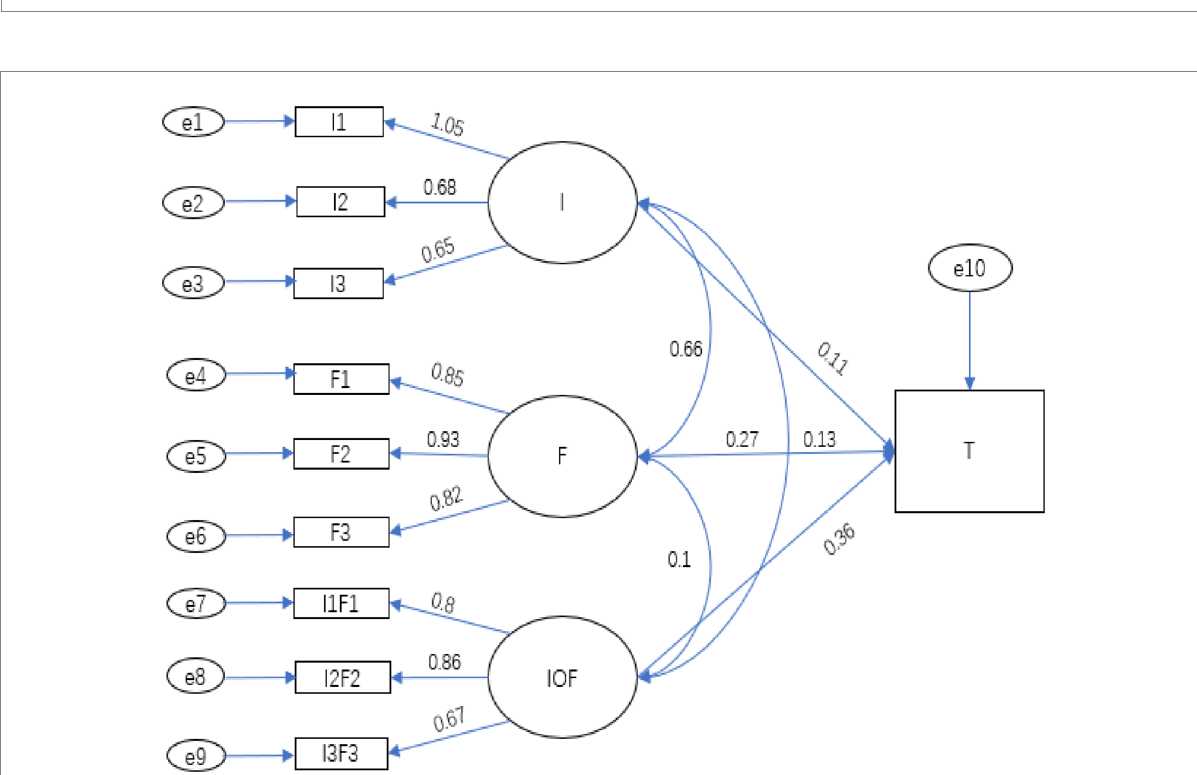
FIGURE 4 Pathways from opportunity (perceived as an obstacle) to fraudulent